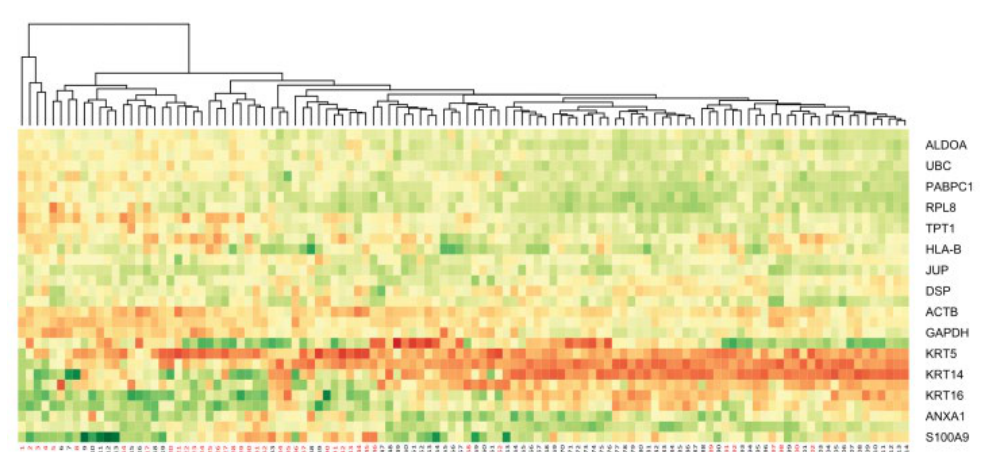
Figure 2. Clustering of the TCGA HNSCC HPVP and HPVN samples and genes. PCA and heatmap clustering shows distinct patient groups as we classify them. ( A ) PCA shows that patients classify in two separate groups for the most part, confirming that separation in HPVP and HPVN groups by p16 expression and in situ hybridization was a valid parameter; ( B – E ) are heatmaps of the most